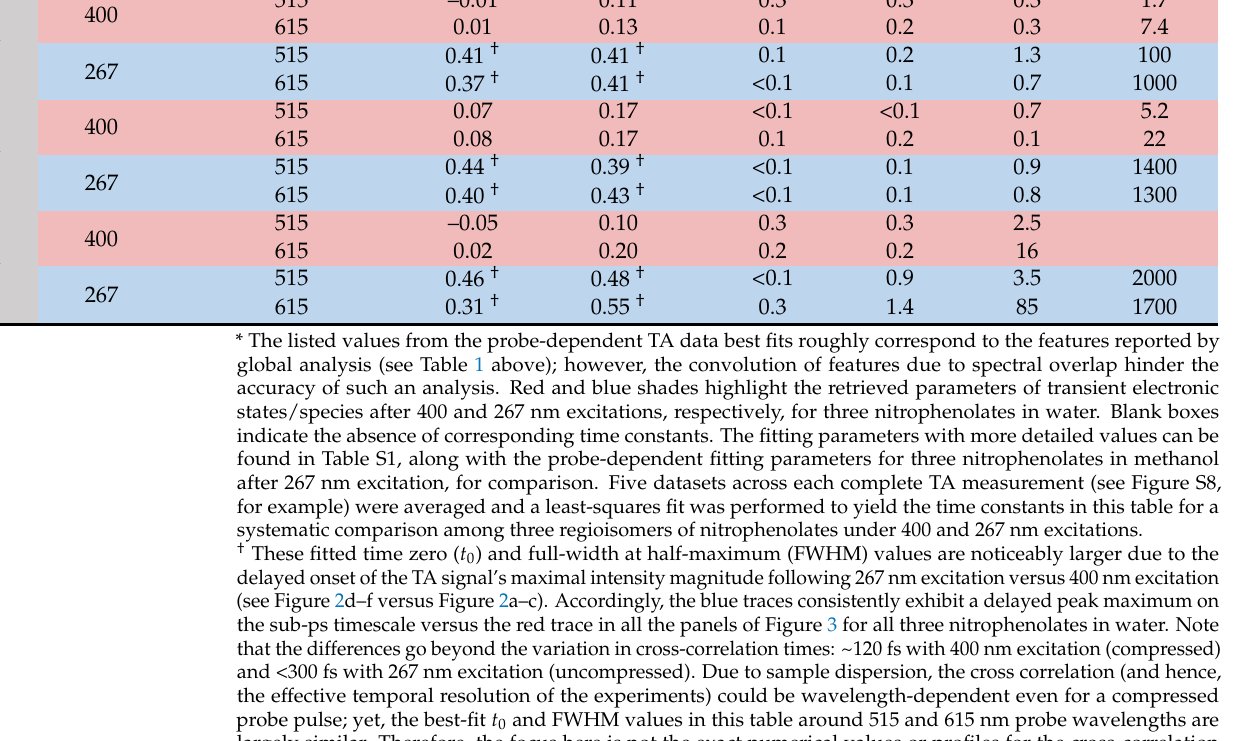
Table 2. Probe-dependent fitting parameters of nitrophenolates in basic water, retrieved from Figure 3 *. Molecule Exc. (nm) Region Center (nm) t 0 (ps) FWHM (ps)